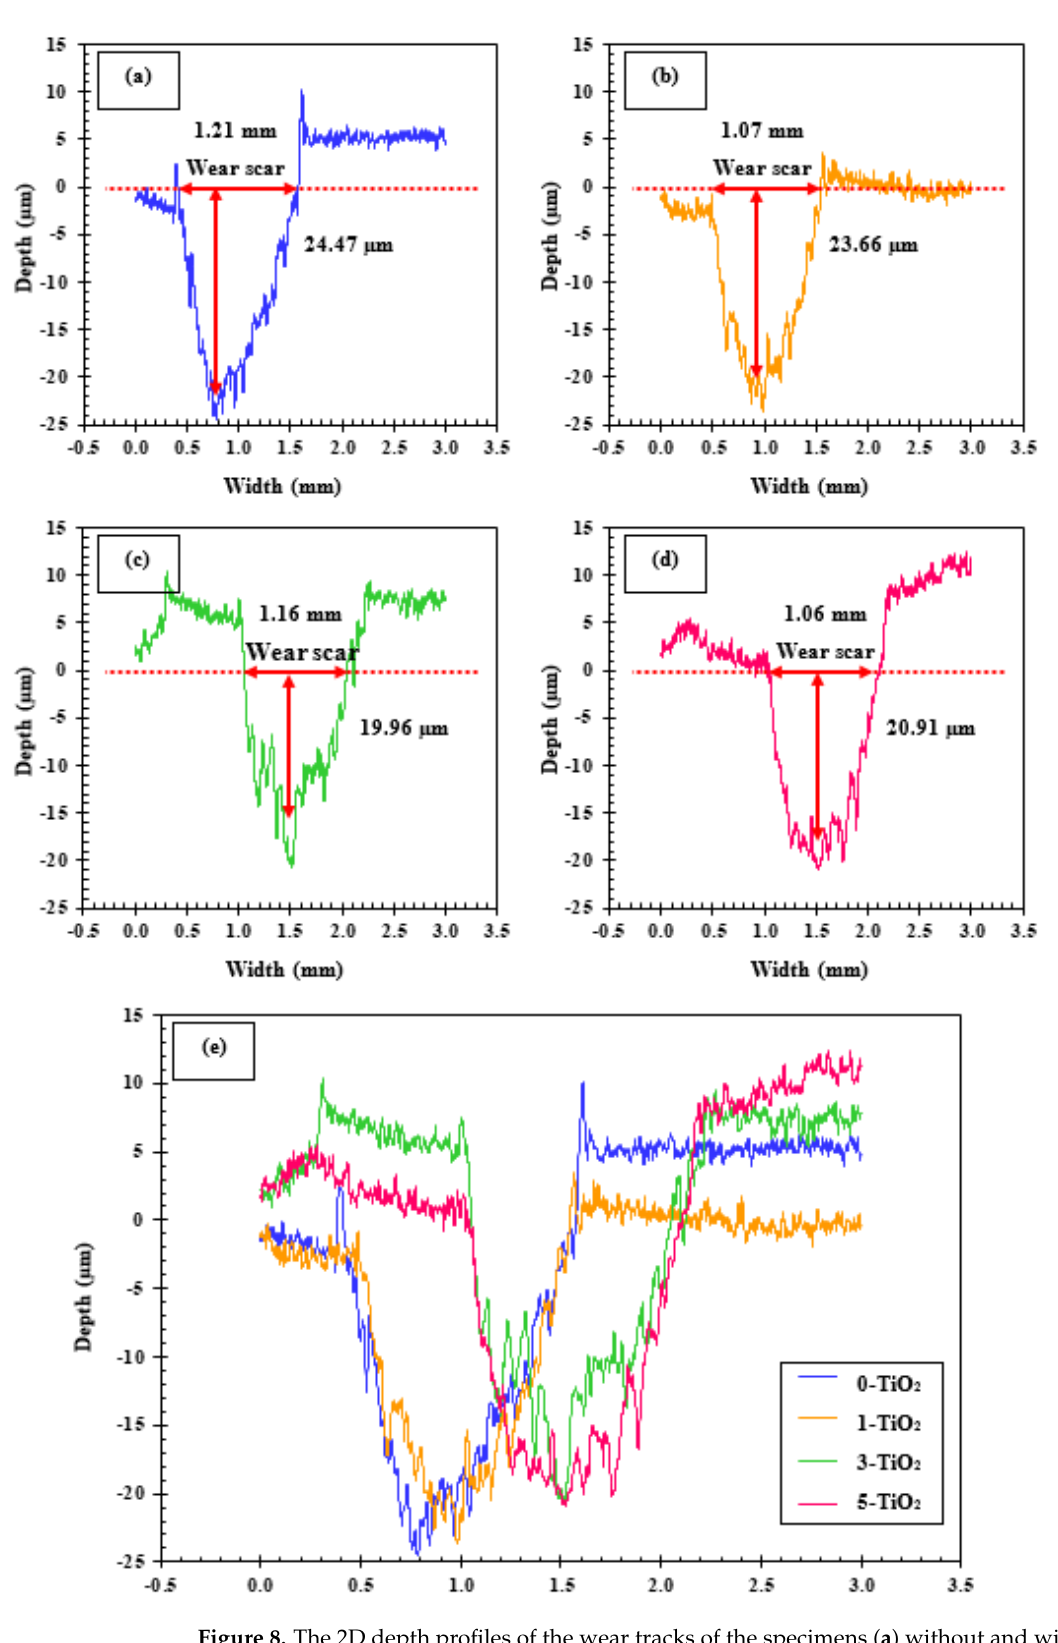
Figure 8. The 2D depth profiles of the wear tracks of the specimens ( a ) without and with ( b ) 1 g/L, ( c ) 3 g/L, and ( d ) 5 g/L of anatase TiO 2 nanoparticles, and ( e ) overall view of all profiles obtained after the ball-on-disk wear test in SBF solution.